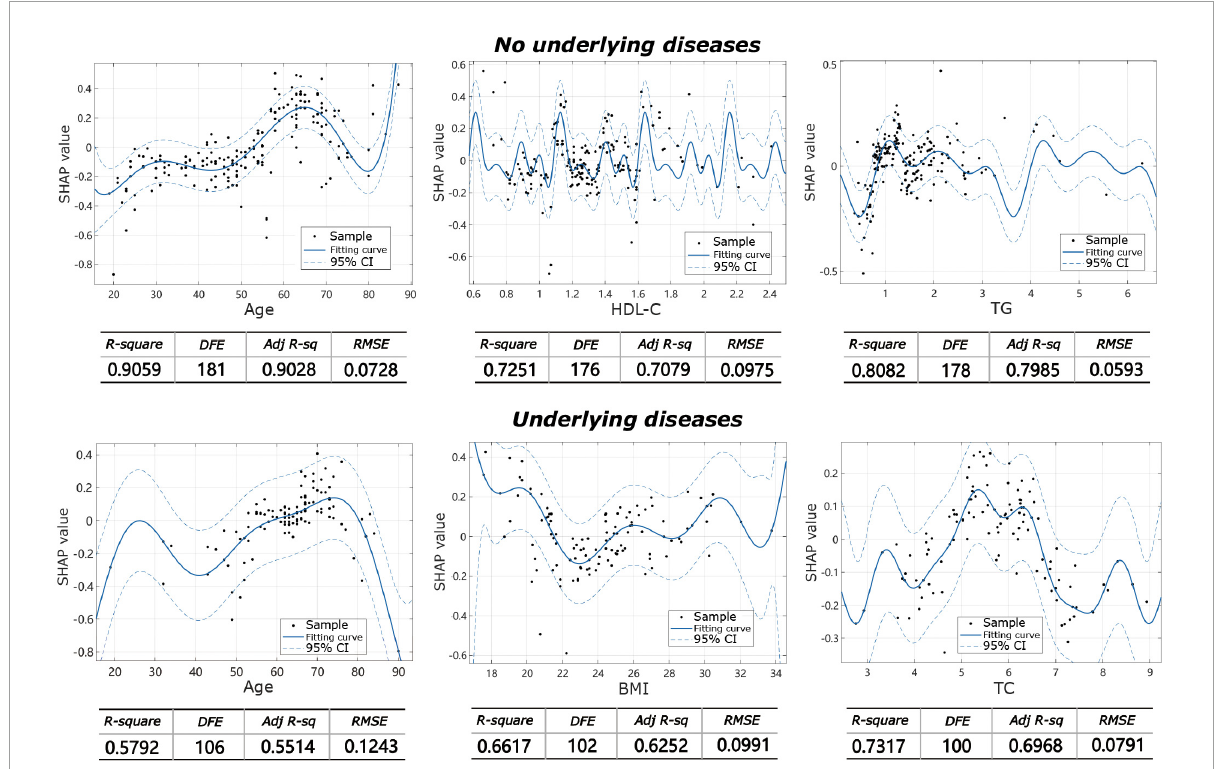
FIGURE5 Fitting effect curves showing the association between SHAP values and contributing factors in facet joint degeneration.